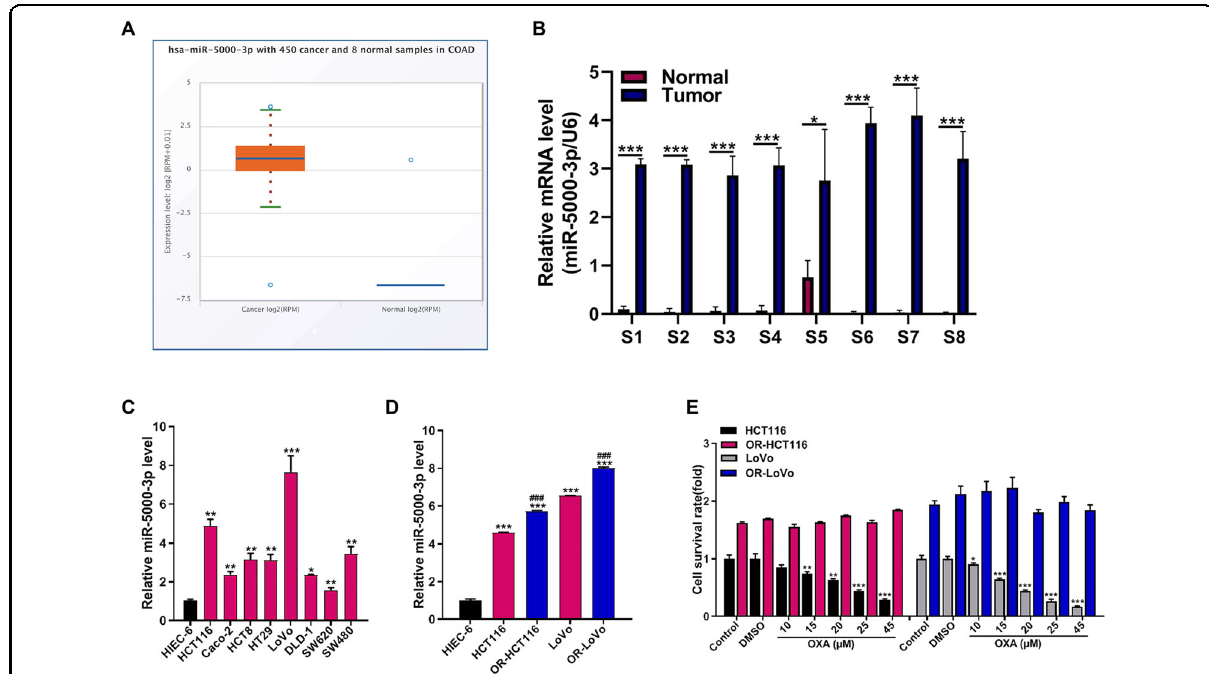
Fig. 1 miR-5000-3p is highly expressed in CRC patients and cells. A The expression levels of miR-5000-3p in normal or CRC tissues from Colon Adenocarcinoma (COAD) were analyzed by starBase online, which was based on the TCGA database (http://starbase.sysu.edu.cn/). B Eight pairs of fresh primary CRC tissues and individual normal para-cancerous tissues were prepared for qRT-PCR against miR-5000-3p. U6 was used as an internal control. C The expression levels of miR-5000-3p in 8 CRC cell lines or normal control cell line from qRT-PCR assay. D The expression levels of miR- 5000-3p in two CRC cell lines (HCT116 and LoVo) or their oxaliplatin (OXA)-resistant cell lines (OR-HCT116 and OR-LoVo) from qRT-PCR assay. E The MTT assay result indicates the survival rate of OR-HCT116 and OR-LoVo cells after treatment with or without OXA (45 µM at 24 h) compared with the HCT116 and LoVo cell control group. * p < 0.05, ** p < 0.01, and *** p < 0.001; ### p <